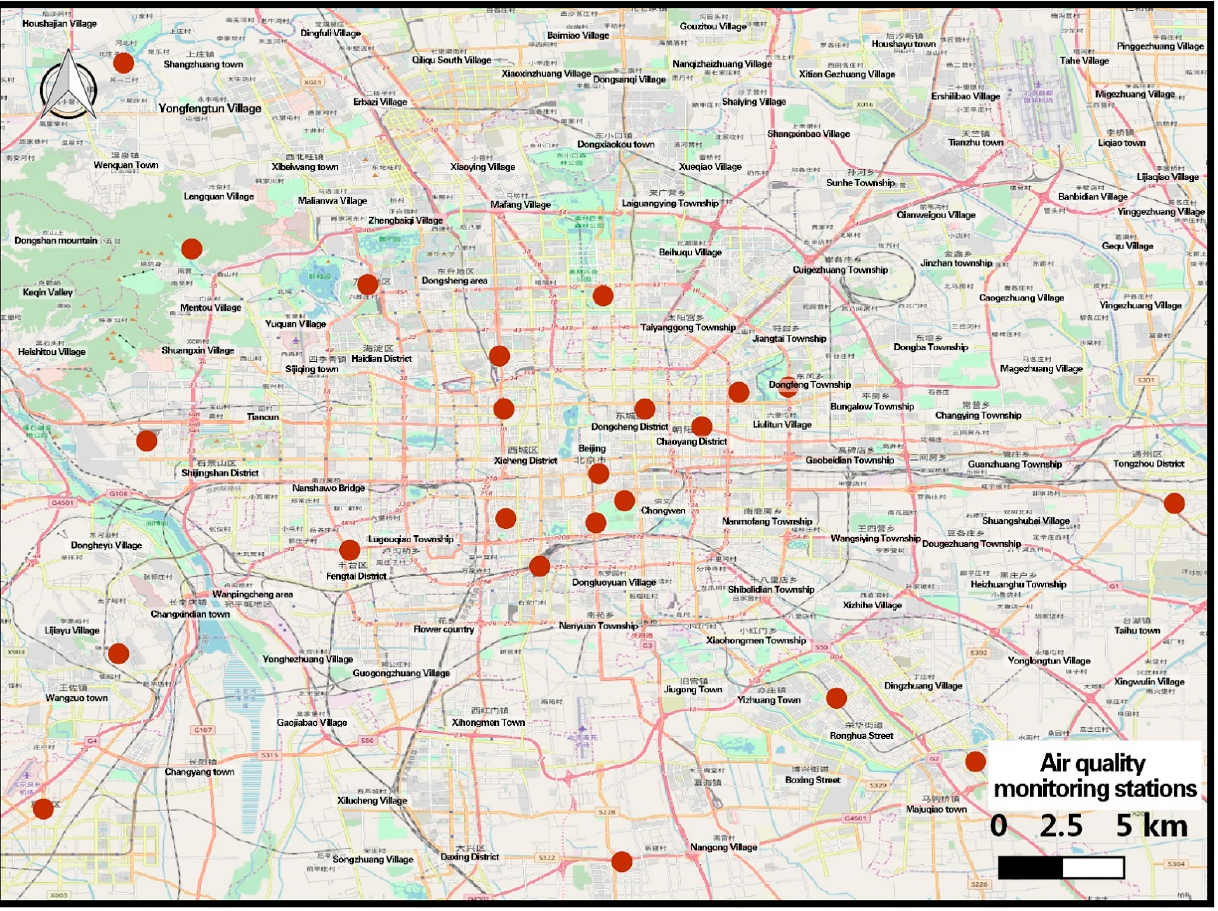
Figure 1. Scope of the study on real-time air quality estimation (covering all 22 air quality monitoring stations built in Beijing before 2013). The red dots indicate air Quality Monitoring Stations.